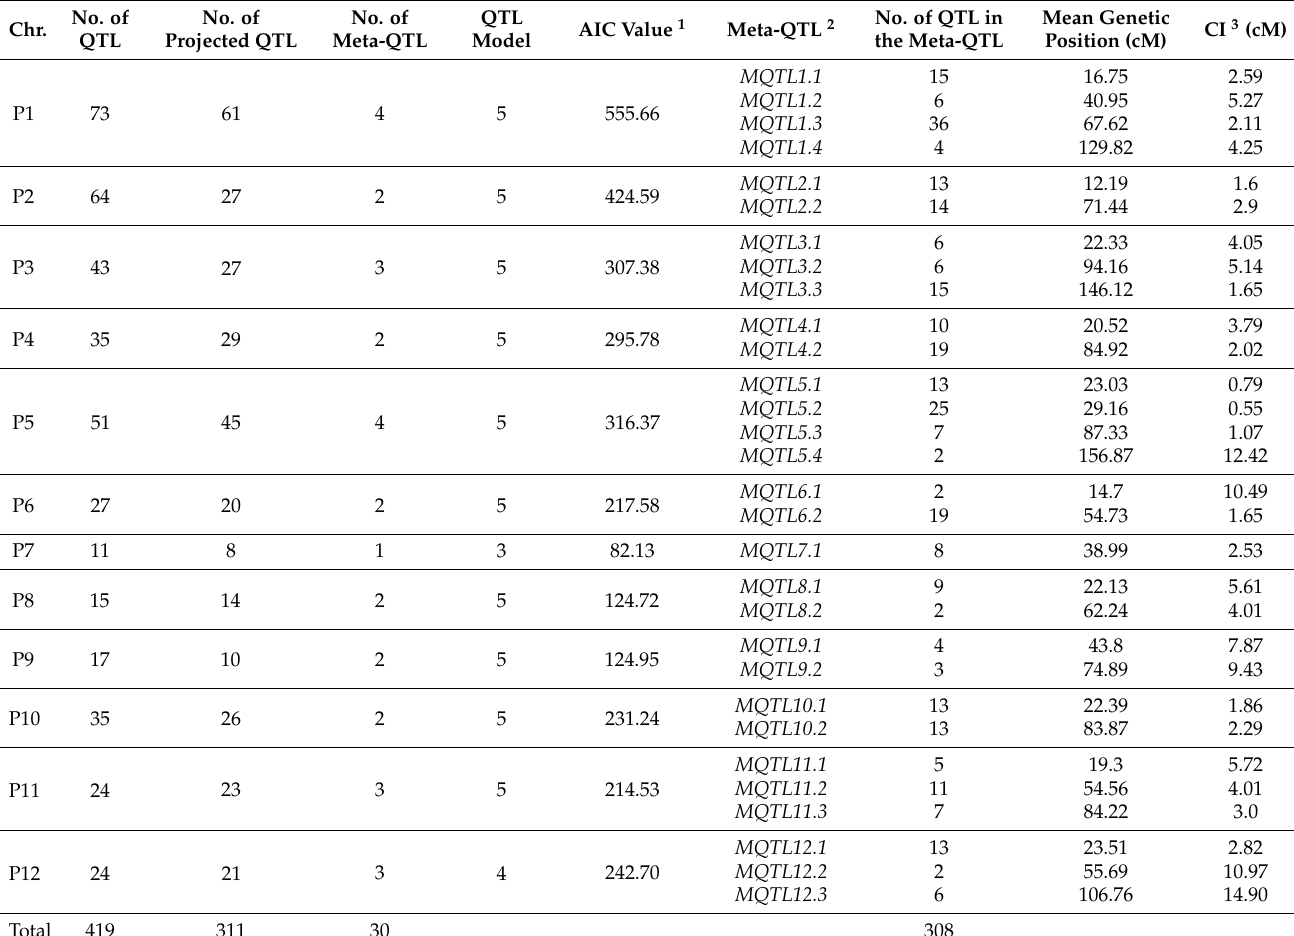
Table 3. Meta-QTL identified for diverse traits in chile peppers ( Capsicum spp.).